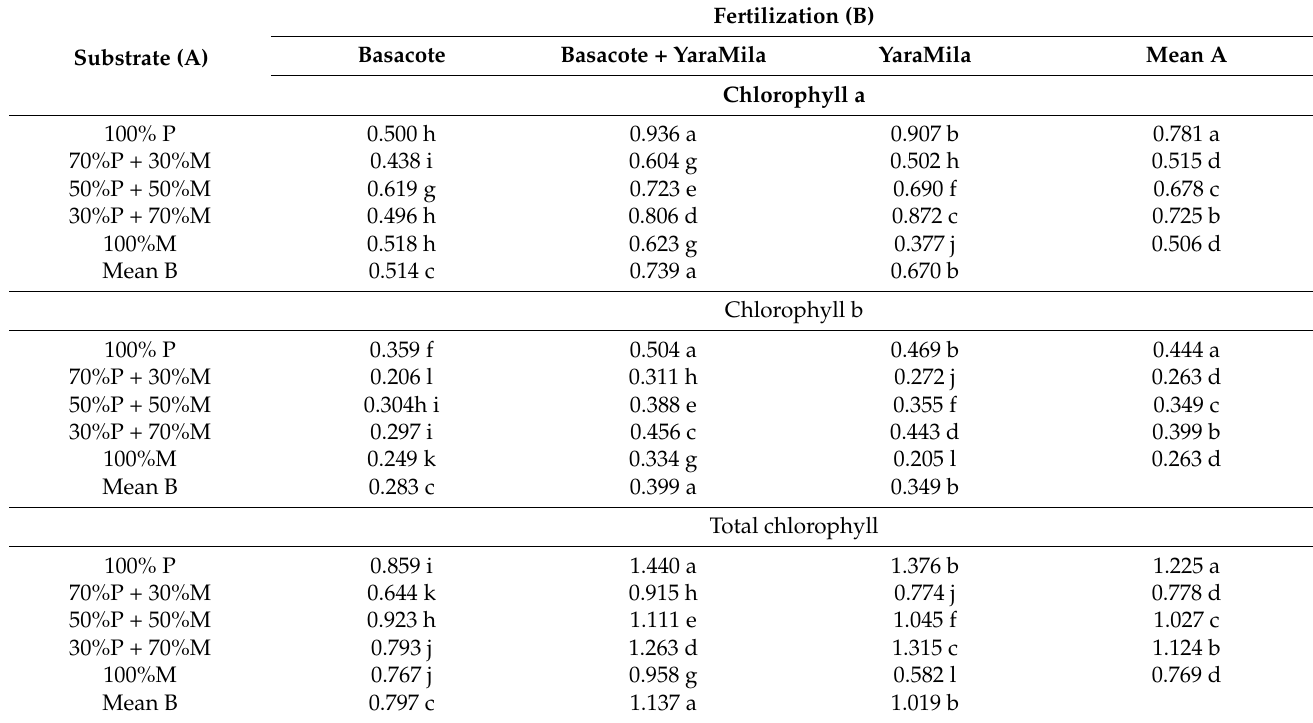
Table 9. Chlorophyll contents (mg/g) in leaves of Hydrangea arborescence ‘Annabelle’ grown in containers with five different substrates.